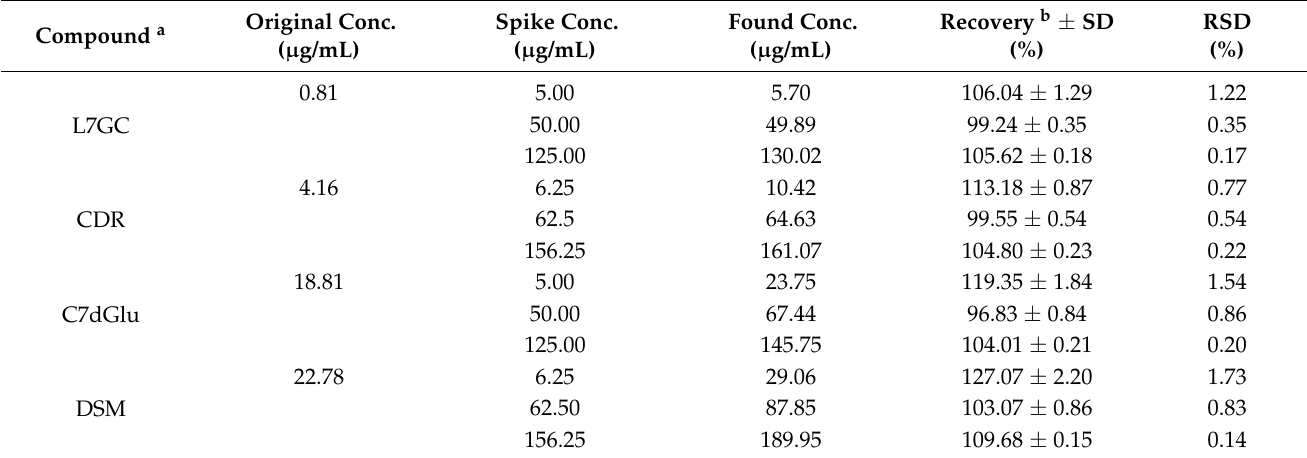
Table 3. Recoveries of L7GC, CDR, C7dGlu, and DSM for the developed HPLC-PDA method ( n = 3).